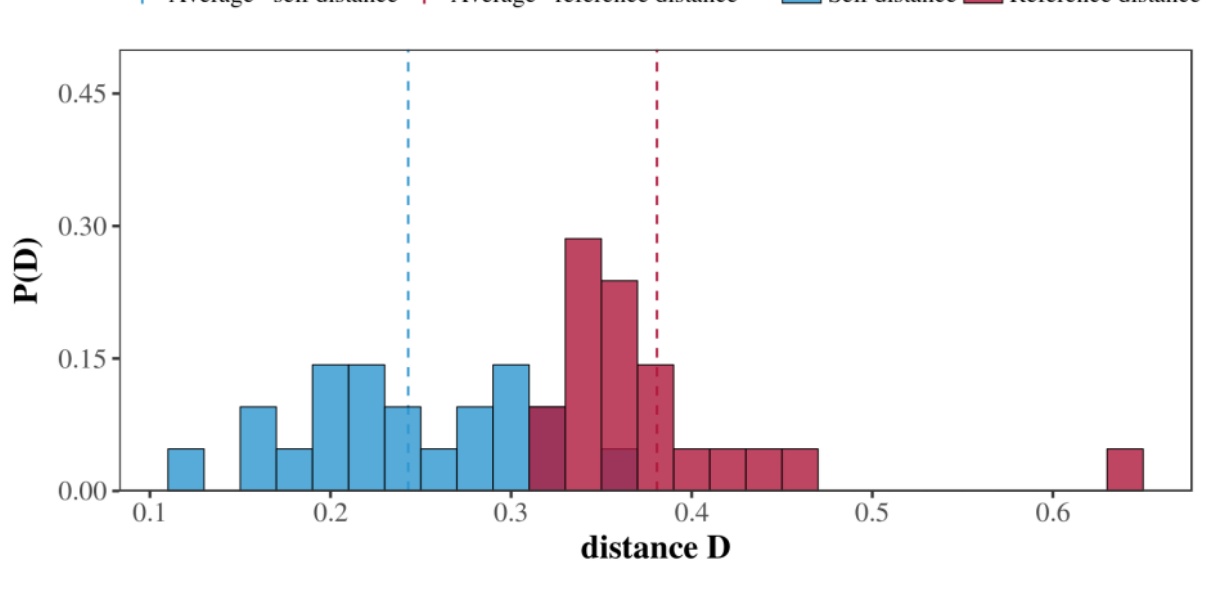
Table 2. Summary of the averaged √ JSD a and Euclidian distance (L2) metrics for the entire population’s references and self-distances.